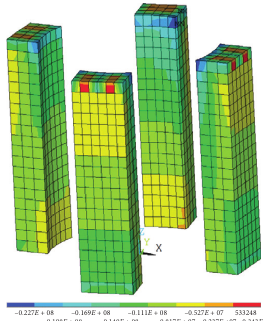
Figure 14: Stress analysis of support columns at the end of the construction process.